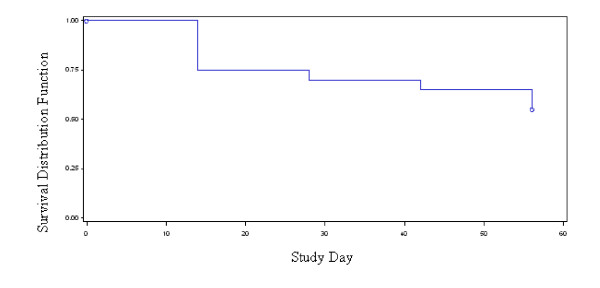
Kaplan-Maier estimates of time to 30 mg/dL or greater reduction in non-HDL cholesterol. Legend: ----- Product Limit Estimate Curve; o o o Censored Observations.